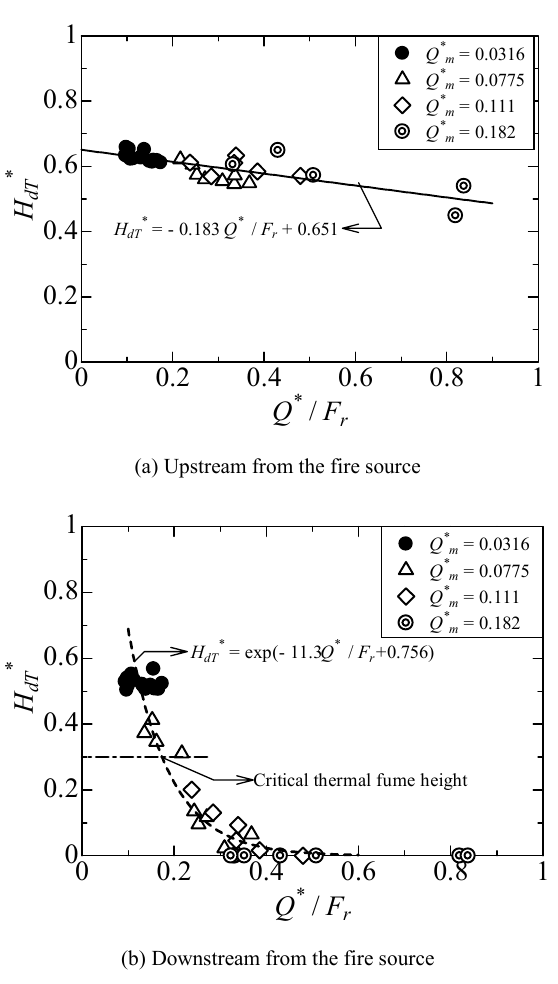
Fig. 10 Modeling of the thermal fume height as a function of Q * / Fr ( δ T = 10 K)